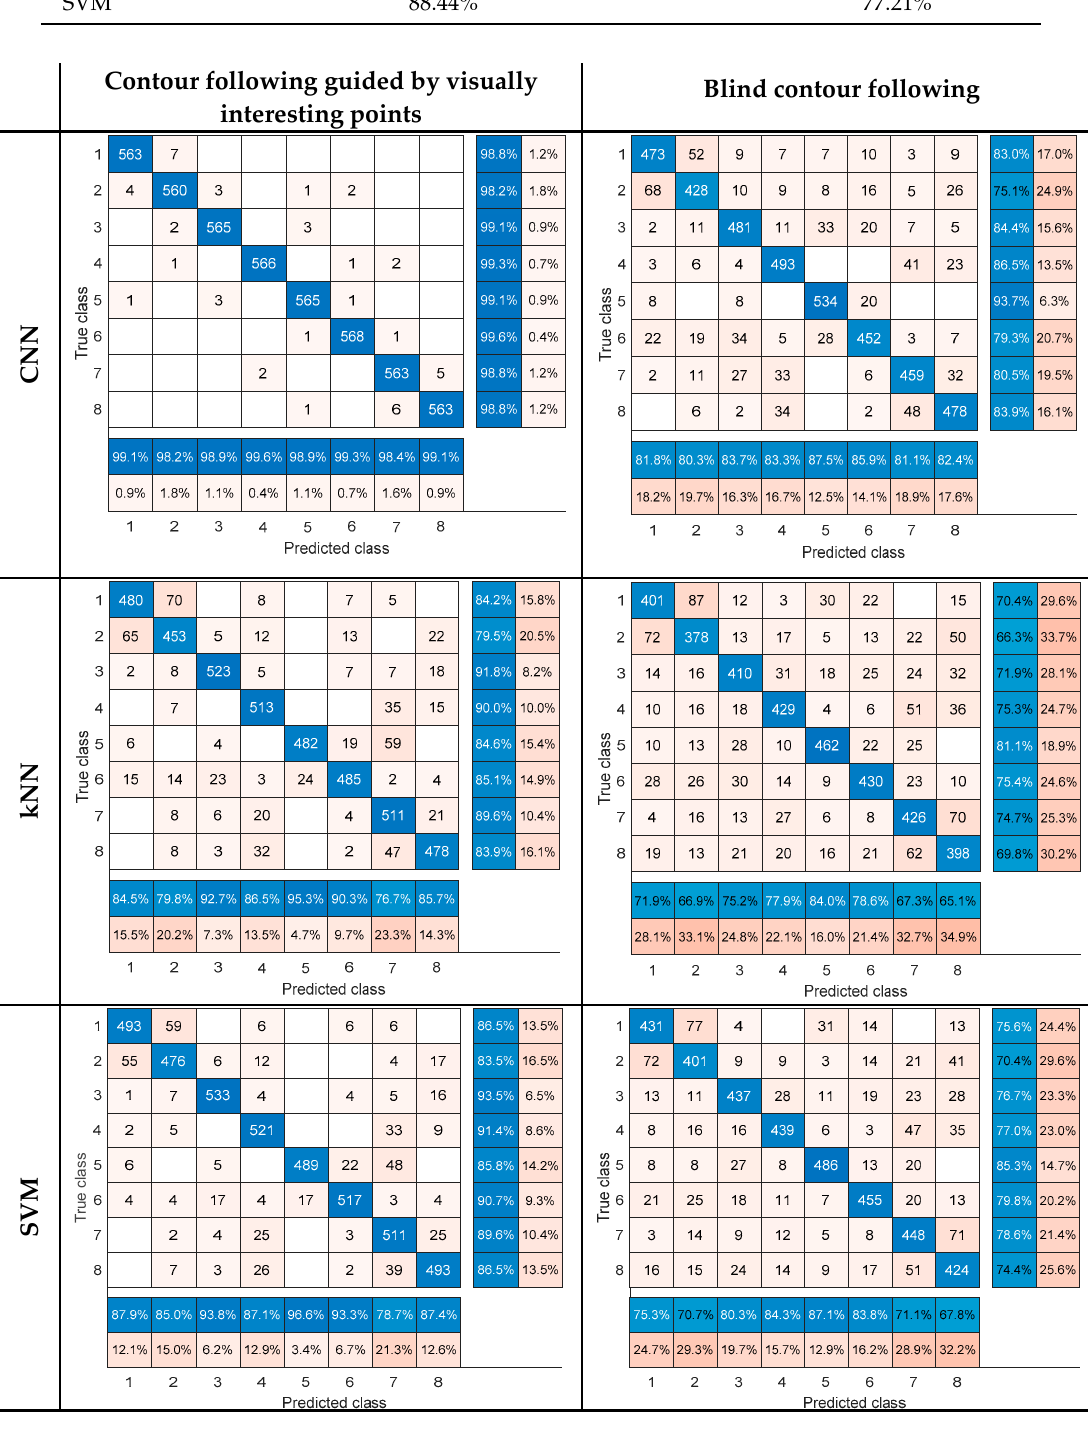
Figure 10. Confusion matrices.